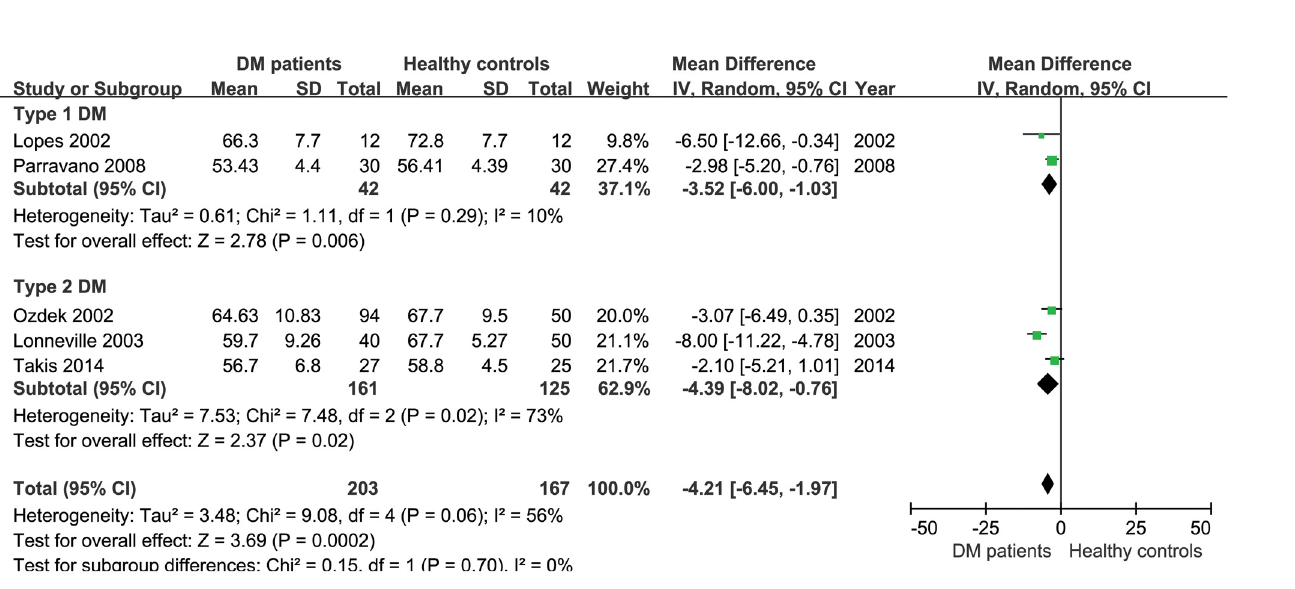
Fig 4. Subgroup analysis of average RNFL thickness of type 1 and type 2 diabetic patients.